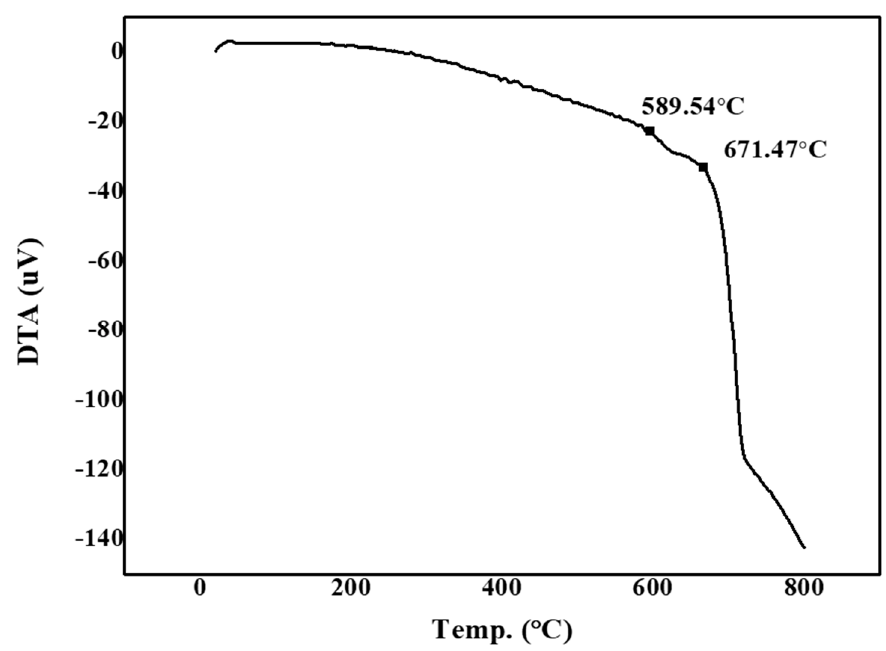
Figure 4. Di ff erential thermal analysis (DTA) results of SiO 2 –B 2 O 3 –RO glass frit (R = Ba, Zn).